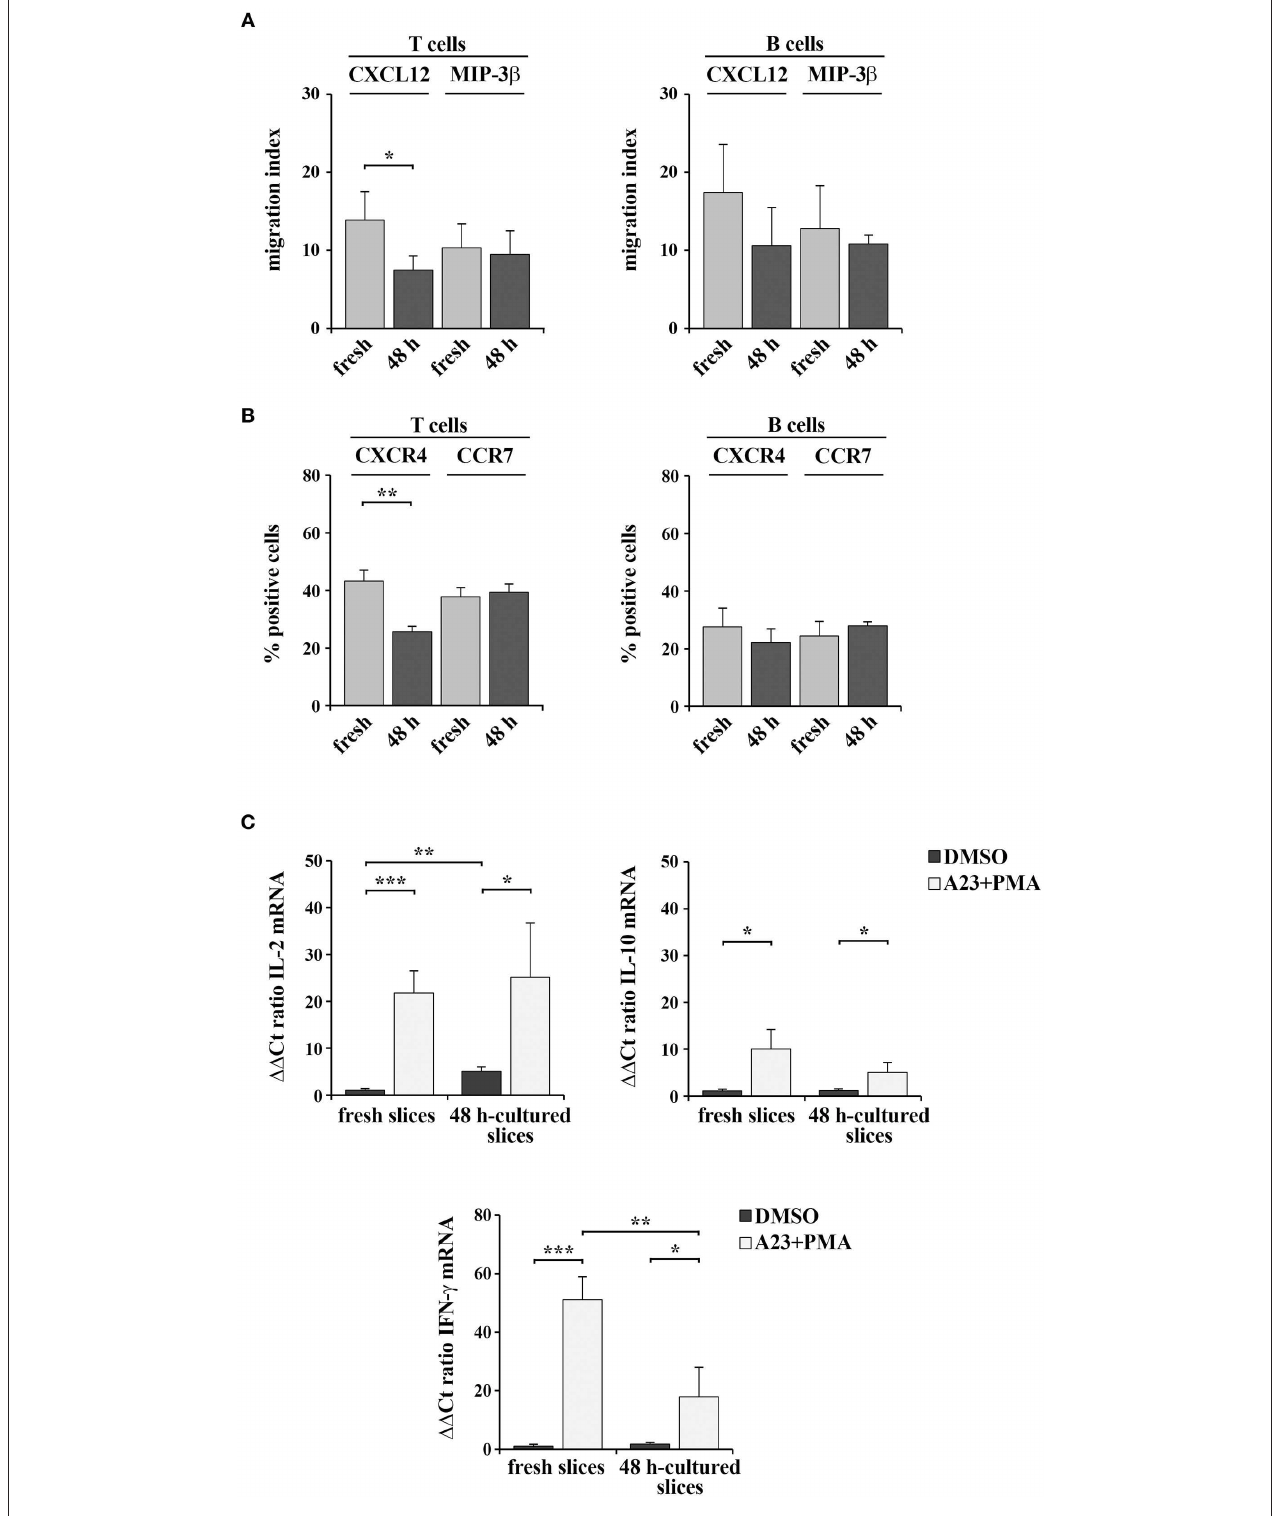
FIGURE 7 | 48 h-culture does not significantly alter spleen slice responsiveness to exogenous stimuli. (A) Migration of T and B cells from intact spleen slices, either freshly prepared or cultured in vitro for 48h and placed on the upper wells of Boyden chambers. Slice-resident T and B cells were allowed to migrate for 3h